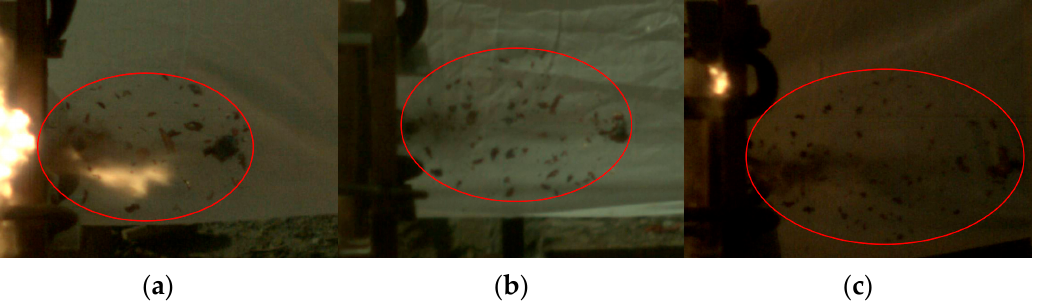
Figure 4. High-speed images of the behind-armor debris cloud. ( a ) L / D = 1.66 ( b ) L / D = 2.4 ( c ) L / D = 3.86.